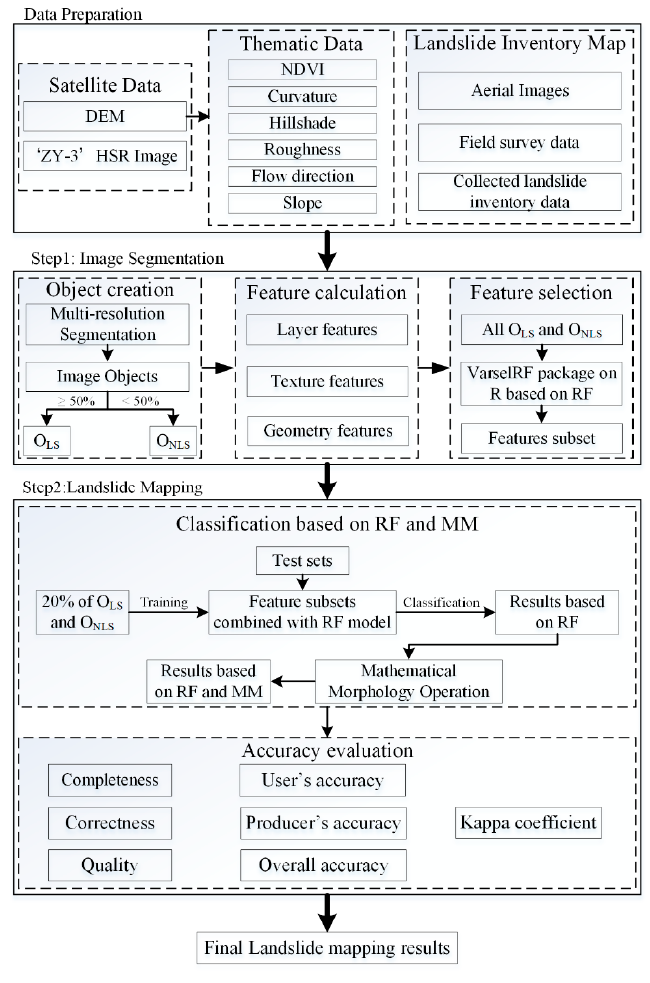
Figure 3. Flow chart of the proposed methods in this study.